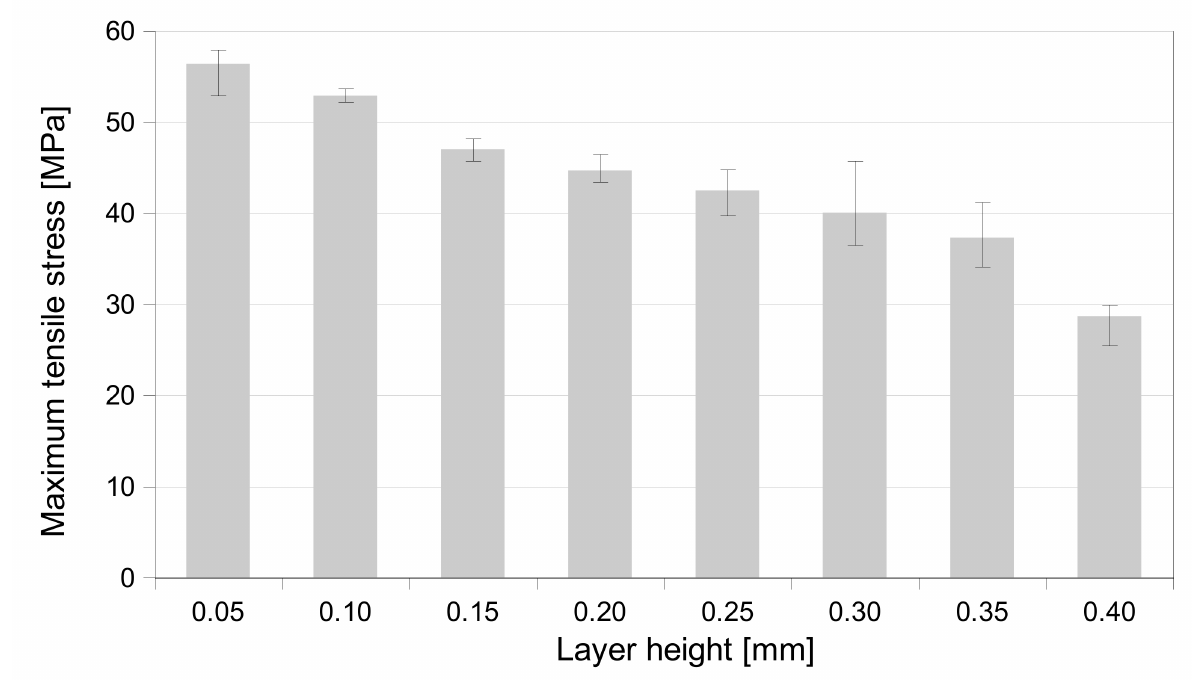
Figure 10. The influence of the layer thickness applied during the printing process on the mechanical properties of the printed